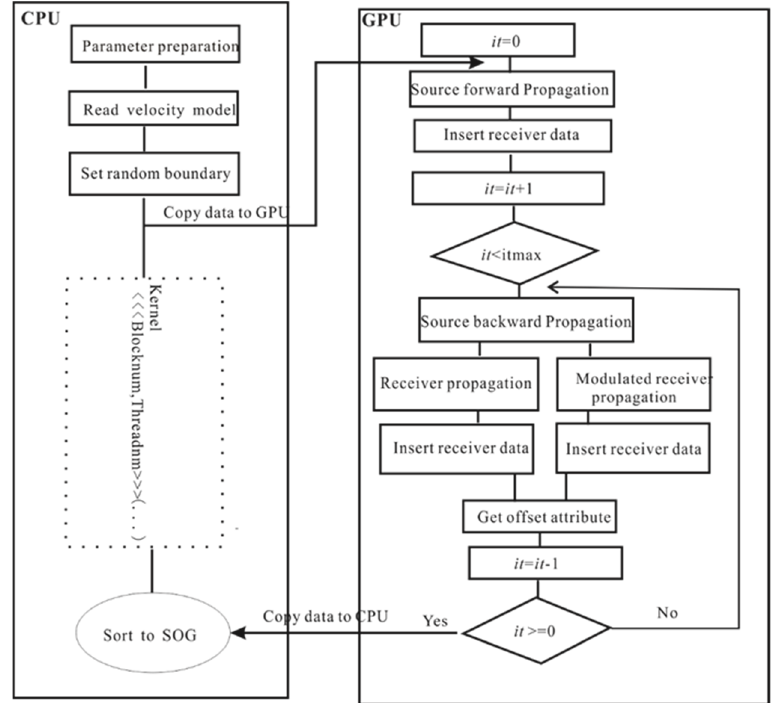
Figure 5. The process for RTM-based calculation to output SOGs.